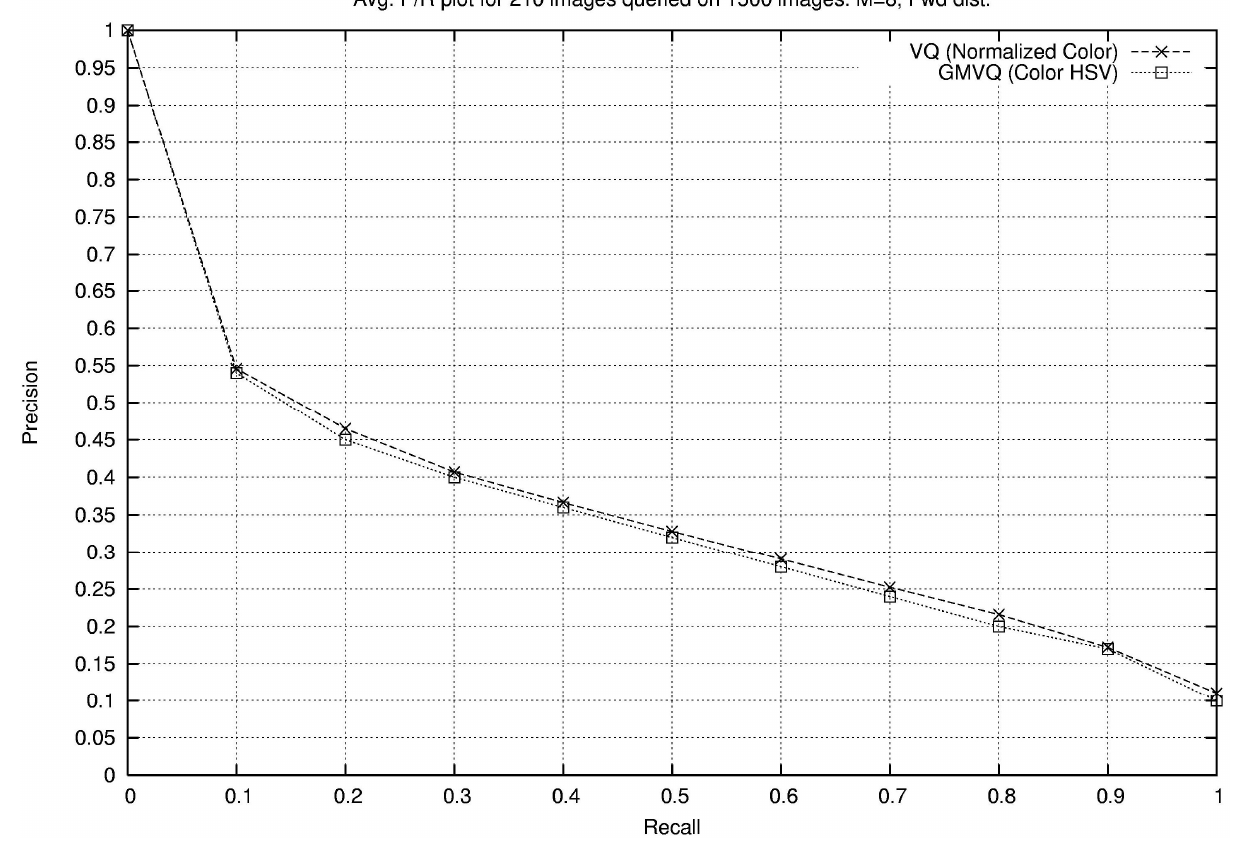
Figure 2. Our VQ (LUV Color) vs. GMVQ (HSV